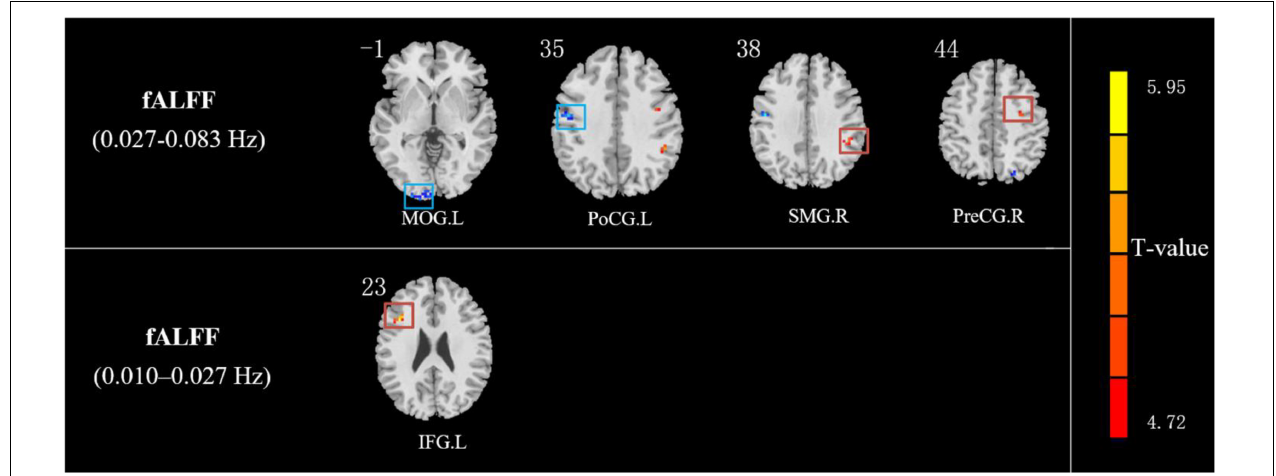
FIGURE 3 | The different fALFF values of brain regions between IXT patients and HCs. The fALFF values in slow 4 (0.027–0.073 Hz) band increased in the right SMG and right PreCG and decreased in the left MOG and PoCG in IXT patients. The fALFF values in slow 5 (0.01–0.027 Hz) band increased in the left IFG in IXT patients. (GRF corrected, P < 0.05). SMG: supramarginal gyrus; PreCG: precentral gyrus; IFG: inferior frontal gyrus; MOG: middle occipital lobe gyrus; PoCG: postcentral